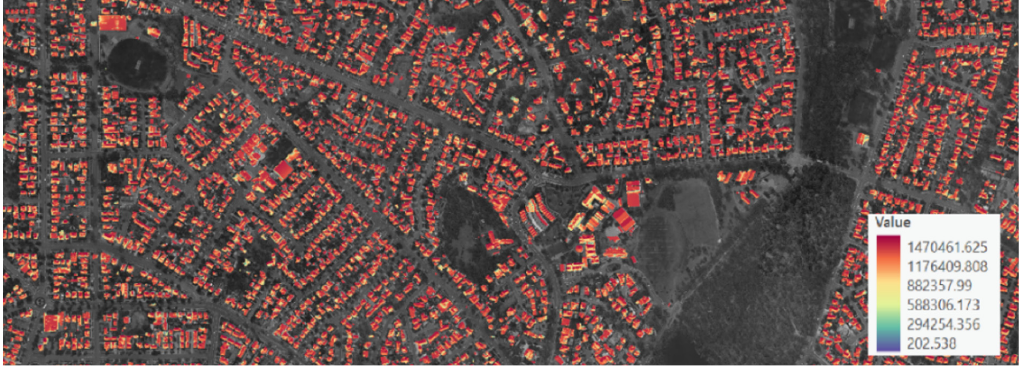
Figure 5. Rooftop solar irradiation potential